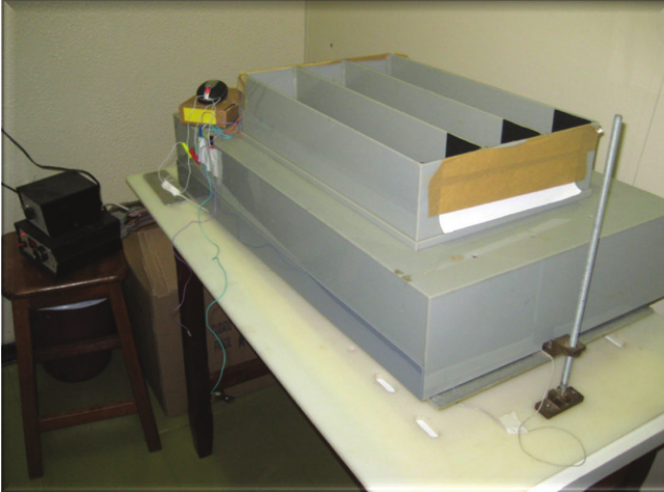
FIGURE 1 - Computed treadmill utilized for gait